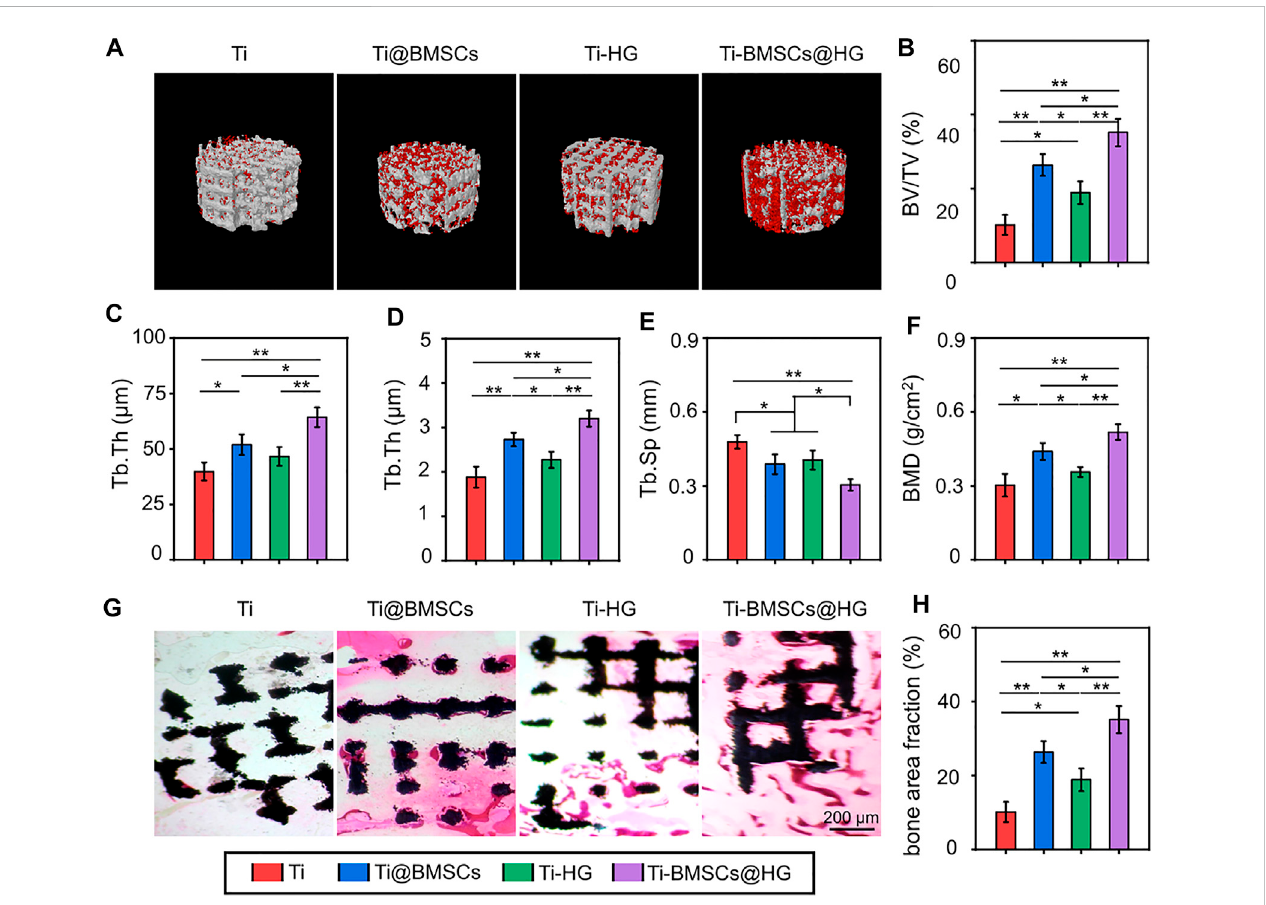
FIGURE 9 (A) 3D reconstruction images of porous titanium alloy prosthesis (white) and new bone formation (red). (B – F) Quantitative analysis of bone morphological parameters, including BV/TV, Tb.Th, Tb.N, Tb.Sp, and BMD according to Micro-CT at 10 weeks after implantation. (G) Representative histological images of H&E staining (The black indicated the porous titanium alloy prosthesis and the red areas indicated the new formation bone tissues). (H) Quantitative analysis bone area fraction by H&E staining (* p < .05 and ** p <